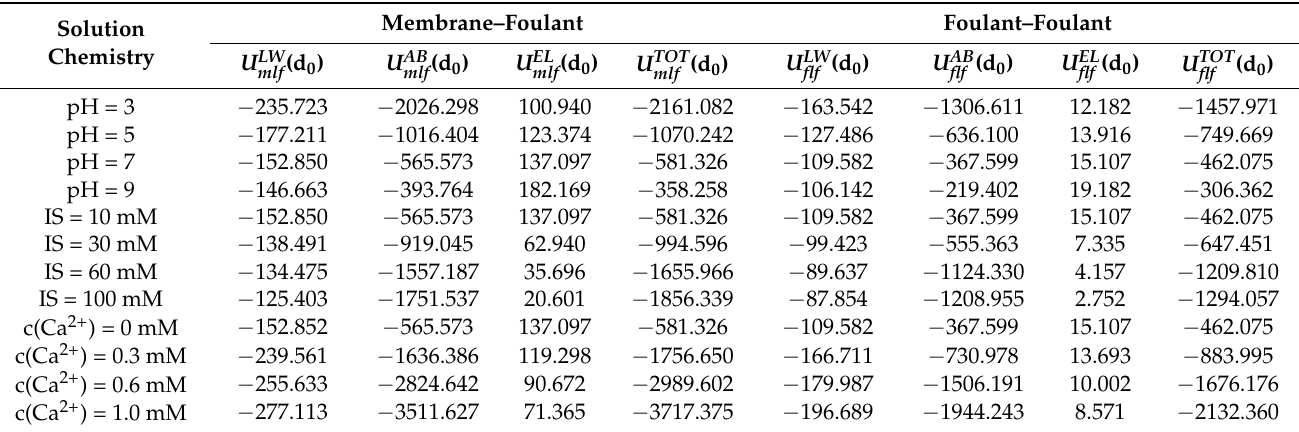
Table 3. Interfacial interaction energies (kT) of membrane–foulant and foulant–foulant pairs at d 0 under different solution